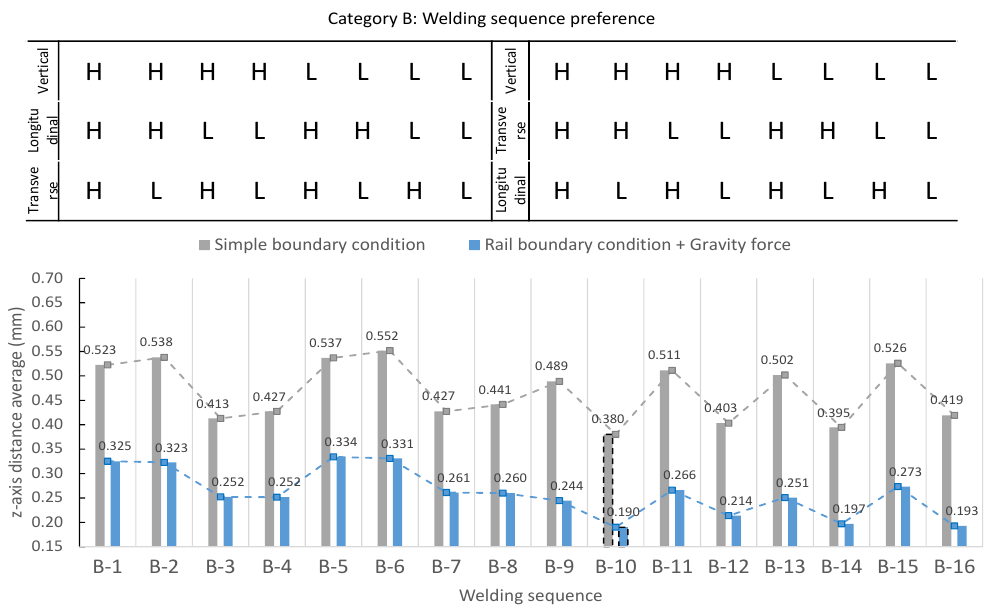
Figure 13. A distance of Category B under two di ff erent boundary condition. Figure 13. 𝐴 𝑑𝑖𝑠𝑡𝑎𝑛𝑐𝑒 of Category B under two different boundary condition.